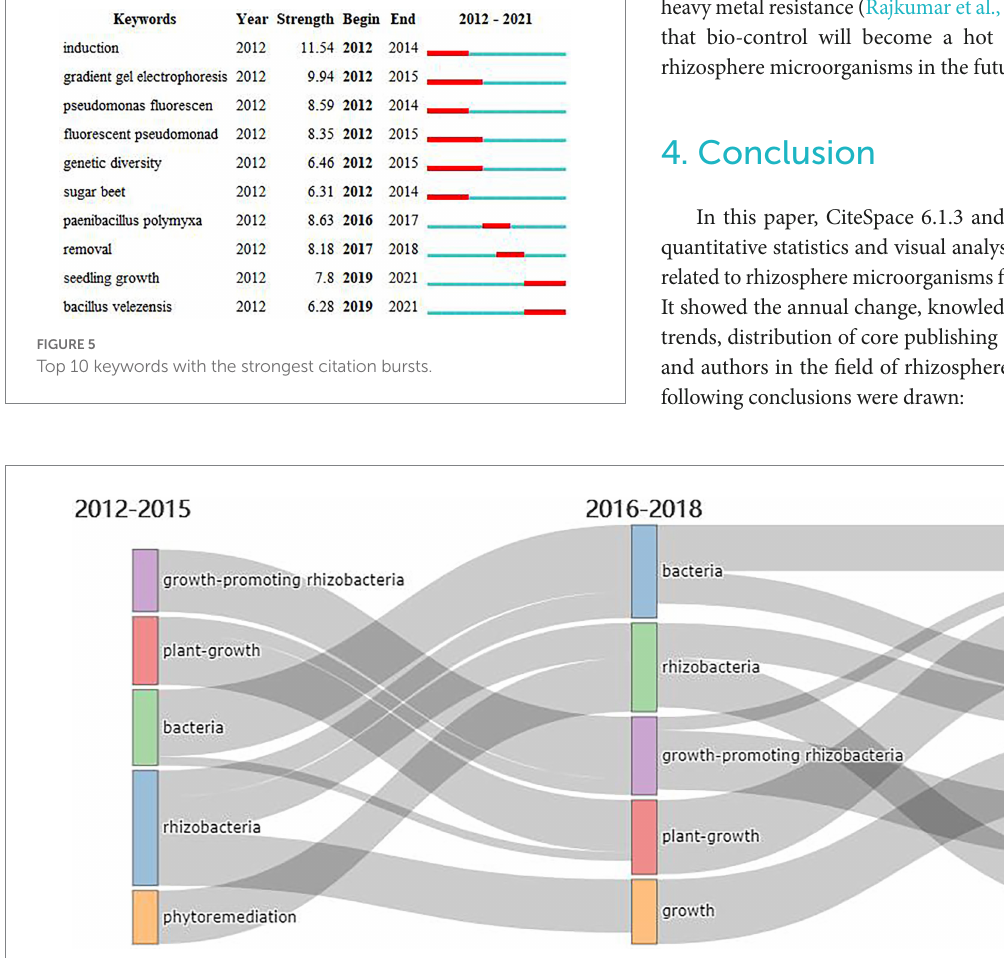
FIGURE 6 Thematic evolution map of publications in rhizosphere microorganism from 2012 to 2021.